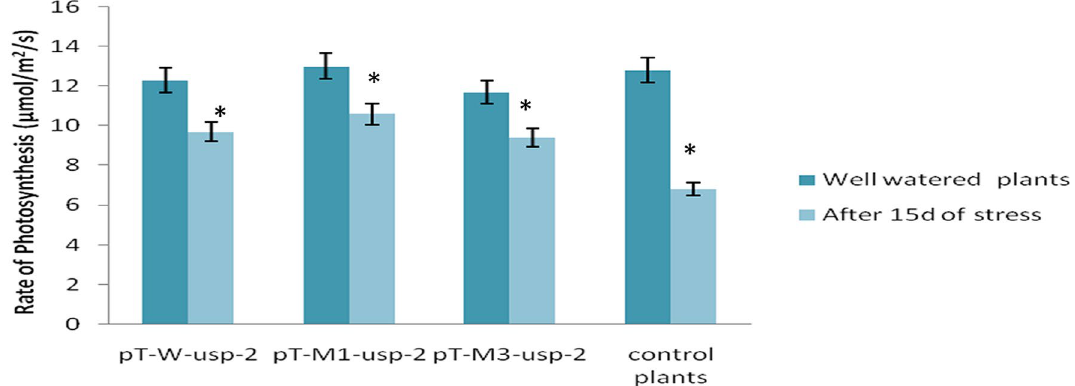
Figure 15. Photosynthetic rate of pT- W-usp-2 , pT- M1-usp-2 , pT- M3-usp-2 plants under control and drought stress conditions.